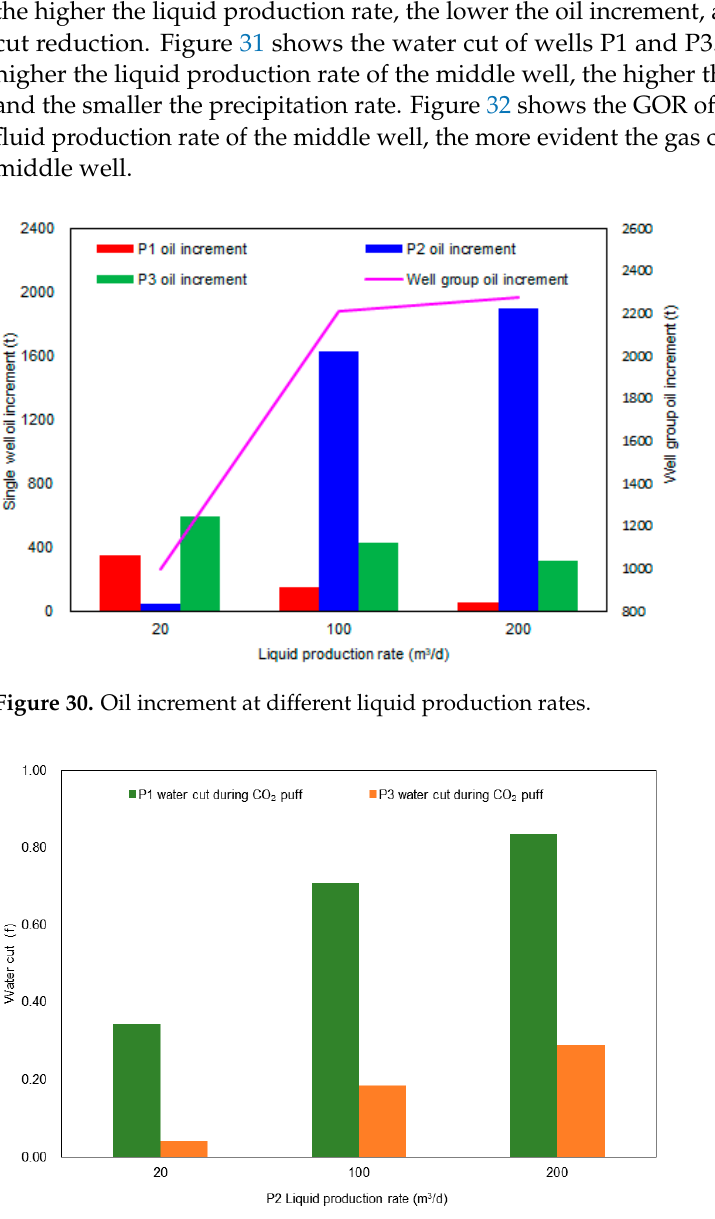
Figure 32. GOR of middle-well P2 with different liquid production rates. 3.2. Results Discussion 3.2.1. Sensitivity of Main Control Factors The sensitivity degree is taken as an indicator to evaluate the sensitivity of factors and is defined as: